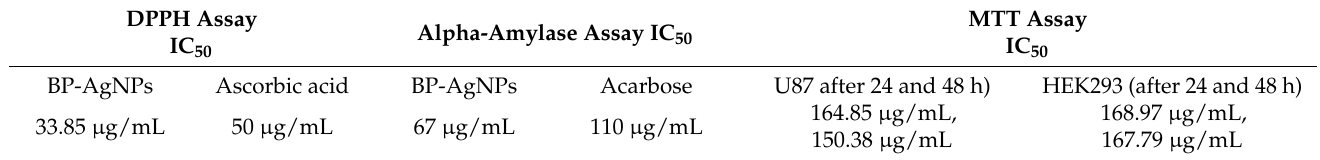
Table 6. Minimum inhibitory concentration IC 50 values for DPPH, alpha-amylase and MTT